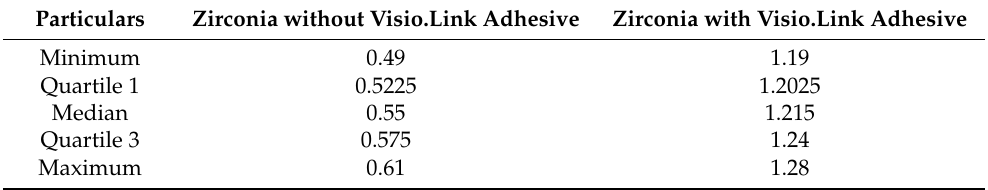
Table 2. Particulars for mean tensile bond strength of Zirconia with and without visio.link adhesive.